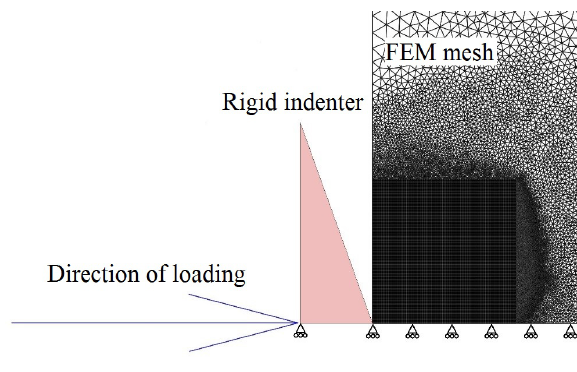
Figure 2. Two-dimensional FEM model of the inden- tation test.